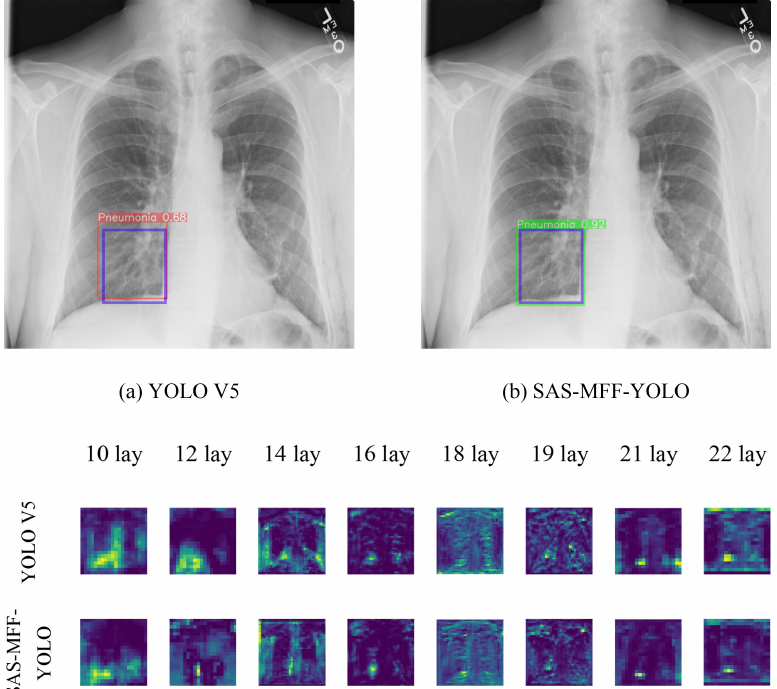
Figure 7. Another example of feature maps visualization. ( a , b ) are the results of lesion detection produced by YOLOv5 and SAS-MFF-YOLO, respectively. The blue bounding boxes are the ground truth, while the red and green ones were labeled by the two models. The heat maps show the selected feature